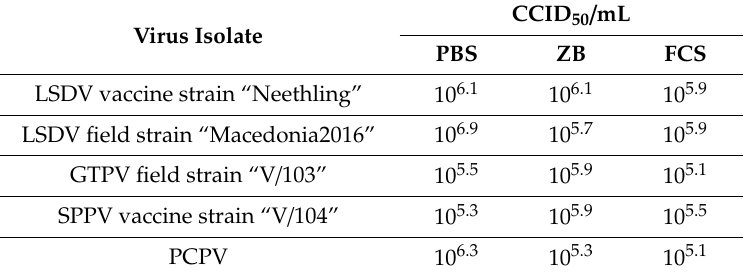
Table 1. Virus titer of material used for thermal inactivation studies. LSDV: lumpy skin disease virus; GTPV: goatpox virus; SPPV: sheeppox virus; PCPV: pseudocowpox; CCID 50 : cell culture infectious dose 50 ; PBS: phosphate bu ff ered saline; ZB: cell culture medium with 10% fetal calf serum; FCS: fetal calf